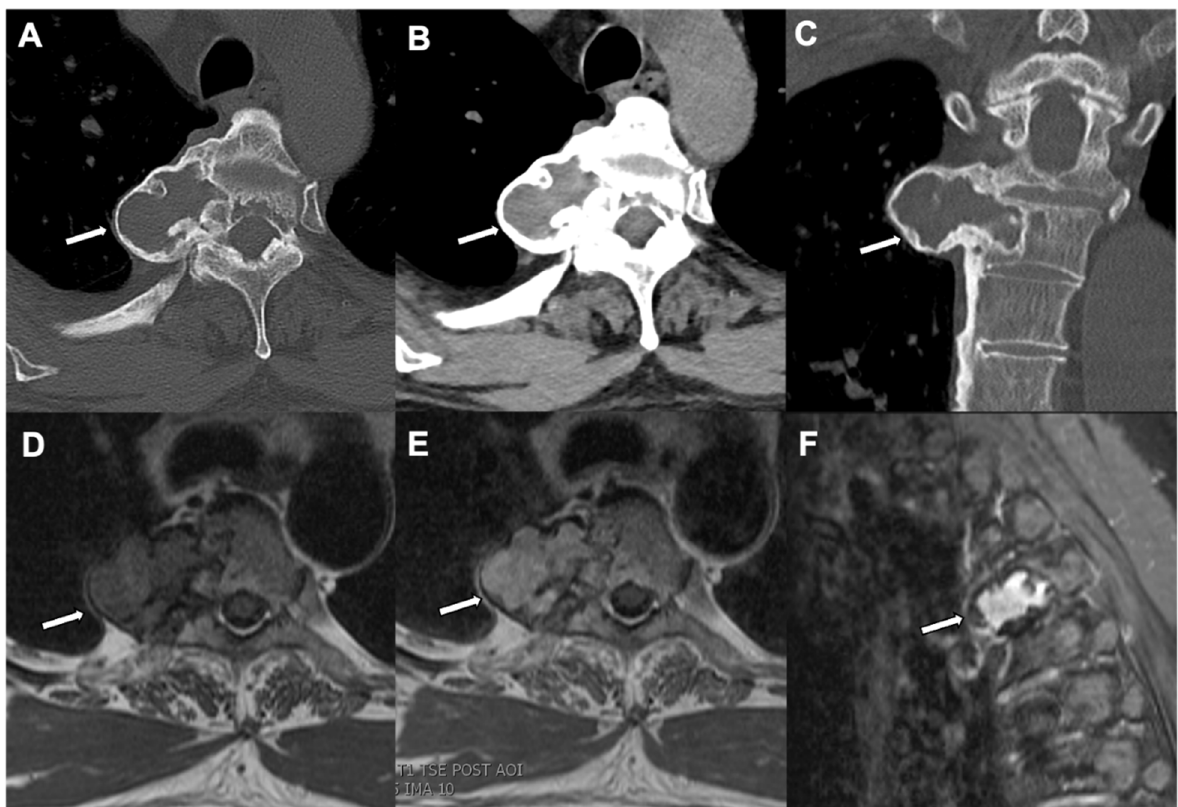
Figure 7. Osteoblastoma: A CT Chest bone window (axial view) ( A ), a soft tissue window ( B ), and CT chest bone window (coronal view) ( C ) in an 18-year-old patient show an expansile lytic lesion (white arrows) with a mineralized matrix and a narrow zone of transition arising from the right pedicle of an upper thoracic vertebra and extending into the vertebral body. An MRI of the chest of the same patient shows a T1 hypointense signal ( D ), a T2 hyperintense signal ( E ), and diffuse enhancement of the vertebral lesion ( F ) in an axial T1-weighted sequence, axial T2-weighted sequence, and sagittal fat saturated T1-weighted postcontrast sequence, respectively.